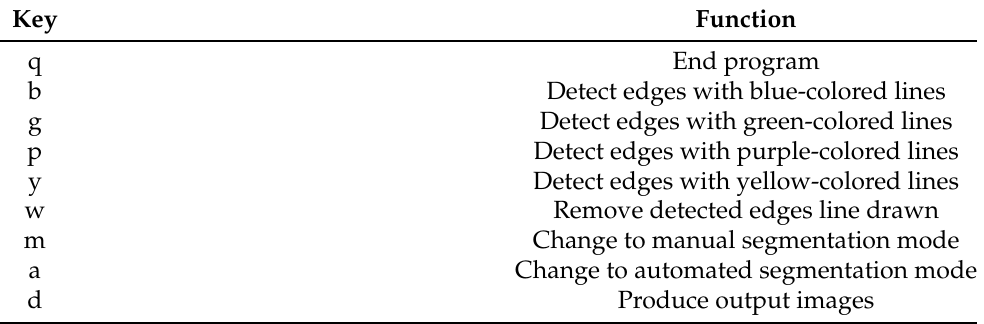
Table 1. Functions of